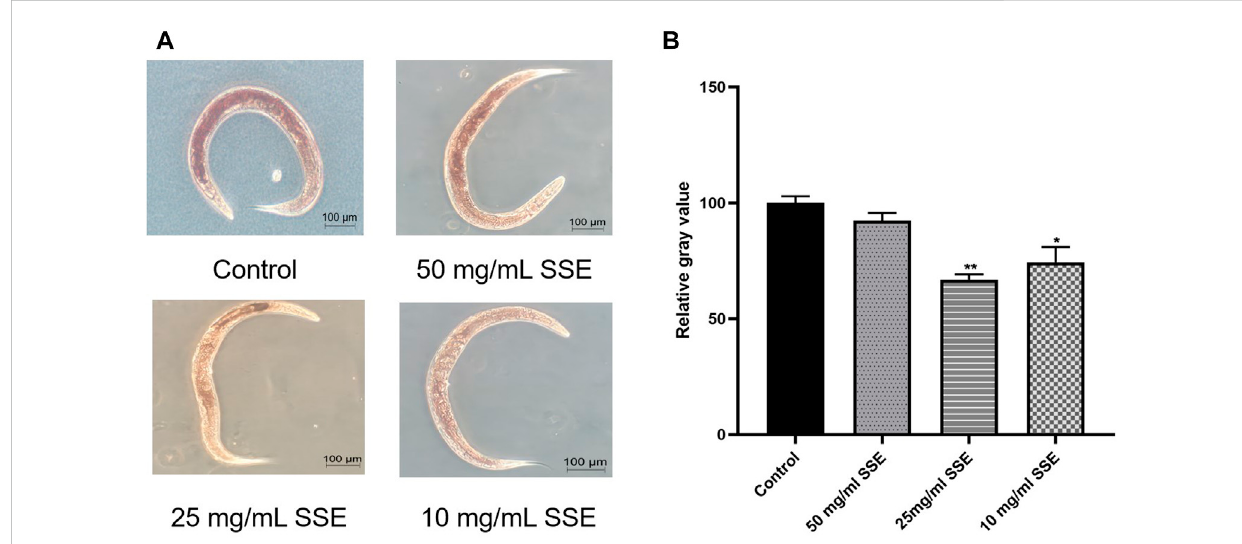
FIGURE 5 SSE acceleratedthelipidmetabolismof Caenorhabditiselegans . (A) RepresentativepicturesoftheresultsofnematodeOilredOstaining. (B) ImageJ software was used to determine the relative grey values. * p ≤ 0.05, ** p ≤